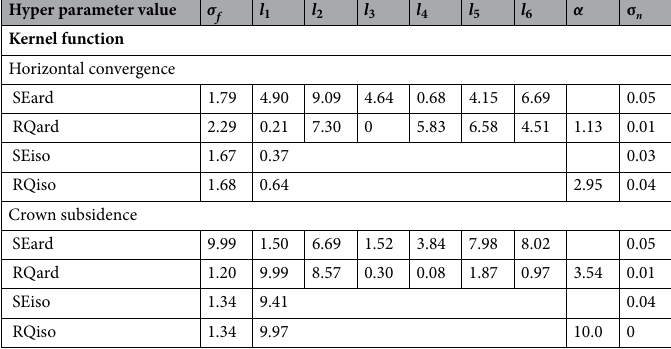
Table 4. Optimal hyperparameters of the best GPR model.